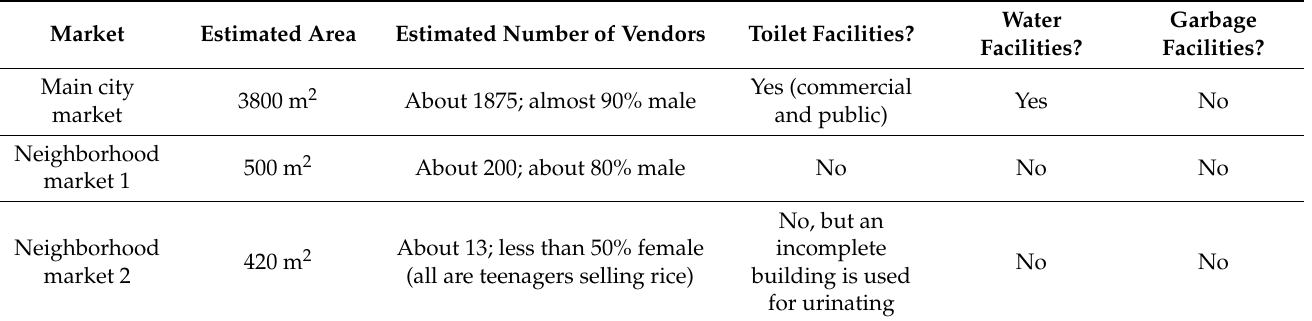
Table 3. Main Market